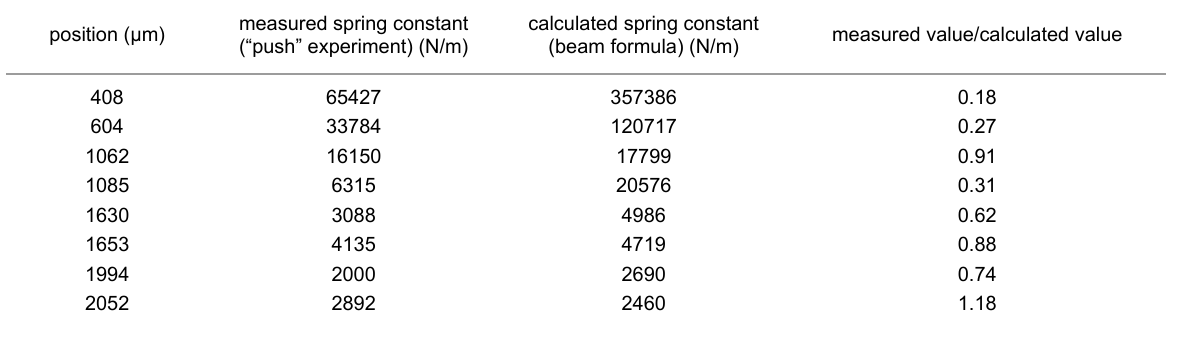
Table 1: Comparison of the measurement of the stiffness with the calculation using the beam formula for the identical position at the prong. measured spring constant calculated spring constant position ( μ m) (“push” experiment) (N/m) (beam formula) (N/m)